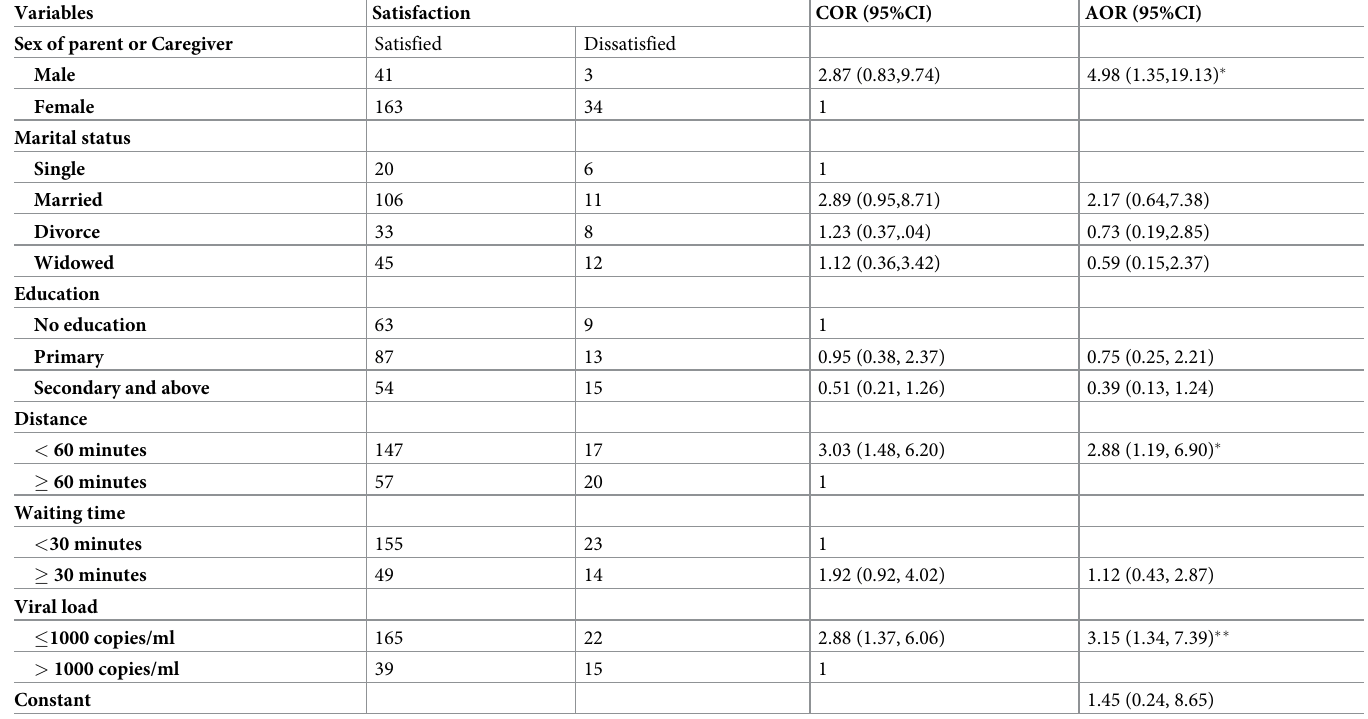
Table 6. Factors associated with caregivers’ satisfaction towards pediatrics ART services in GCAHCs, April 2020.